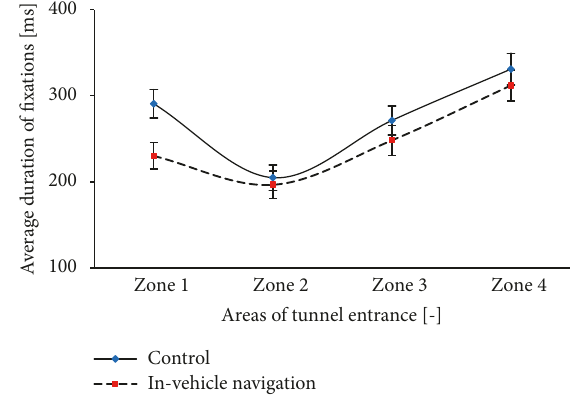
Figure 5: Comparisons of the average duration of fixations between the control condition and in-vehicle navigation